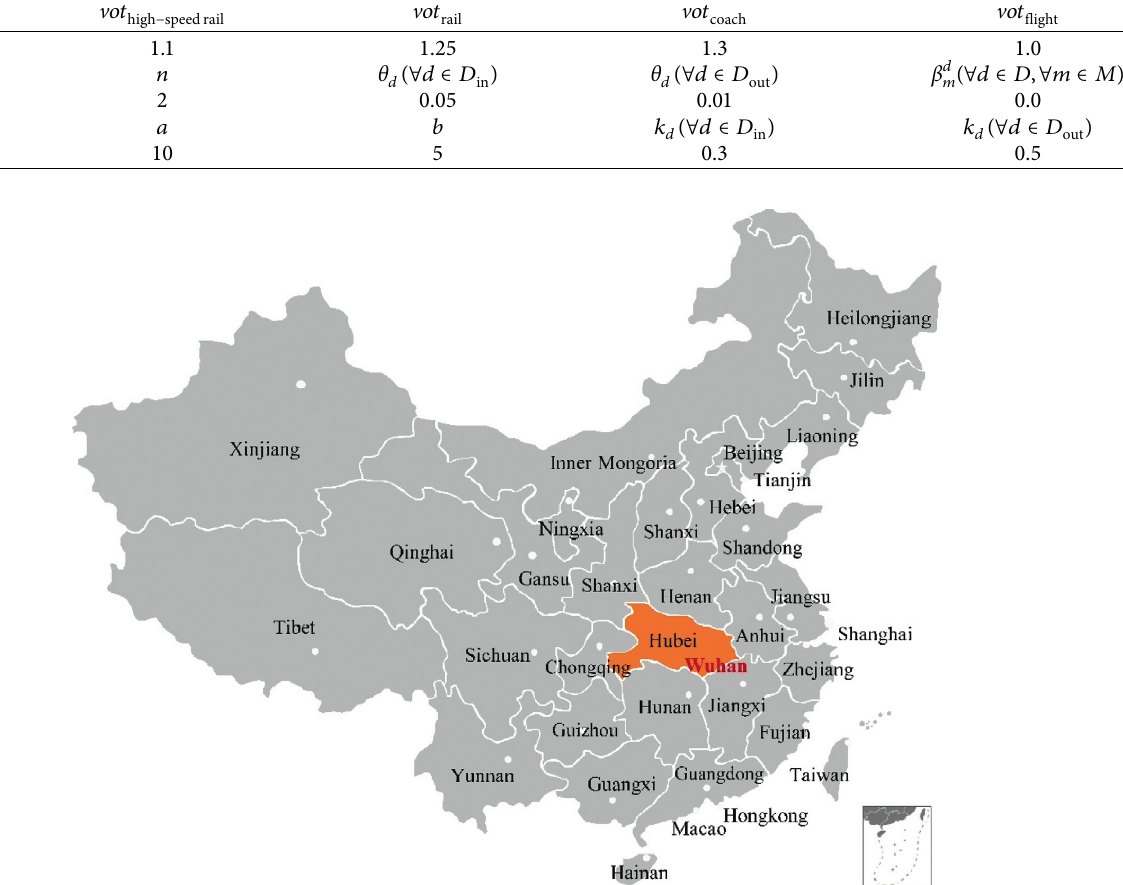
Figure 1: Wuhan and other 35 regions outside the province of Hubei.